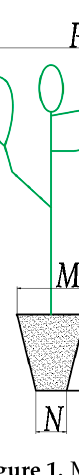
Figure 1. Morphological parameters of pepper plug seedling.